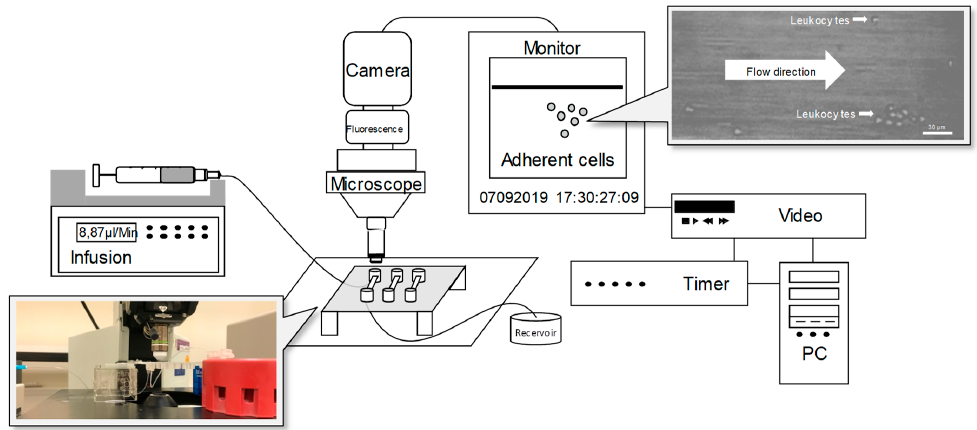
Figure 1. Microflow chamber setup. Neutrophil adhesion of preterm, term infants, and adults was analyzed in dynamic microflow chamber experiments. To mimic blood flow conditions, a high-precision perfusion pump with a 1 dyn/cm 2 wall shear rate and microglass capillaries, which were coated with P-Selectin, intercellular adhesion molecule 1 (ICAM-1), and IL-8 were used. The chambers were connected via PE tubing to a 1 mL syringe containing freshly isolated neutrophils. Permanent adhered cells were counted as neutrophil adhesion per field of view (FOV) after 15 min.